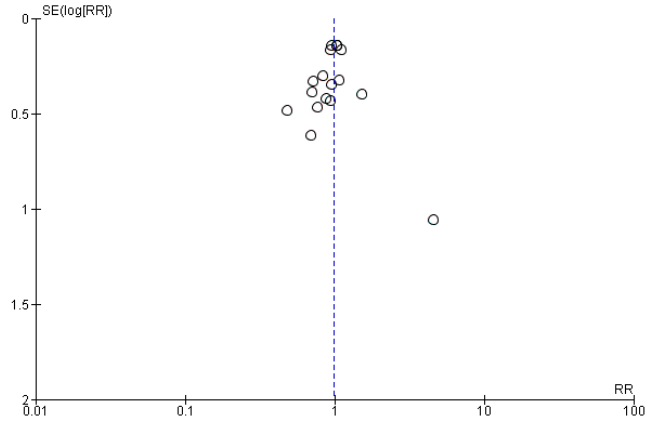
Figure 11. Funnel plot of studies evaluating the administration of probiotic and cesarean section.